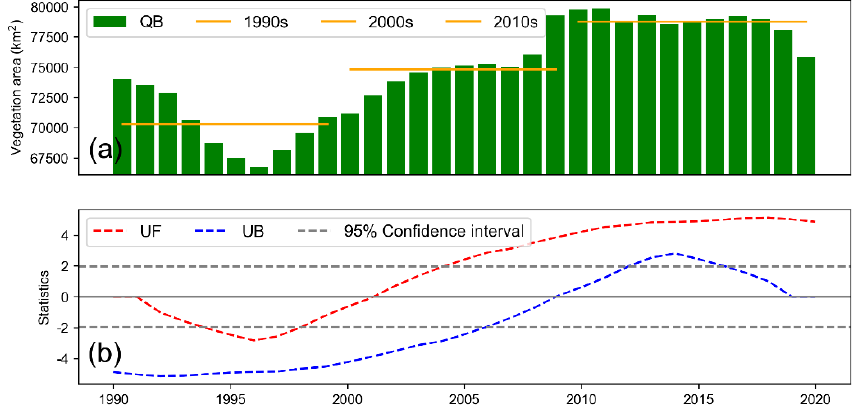
Figure 12. ( a ) Changes of vegetation areas in the Qaidam Basin from 1990 to 2020. ( b ) Mann-Kendall test results of vegetation in Qaidam Basin.